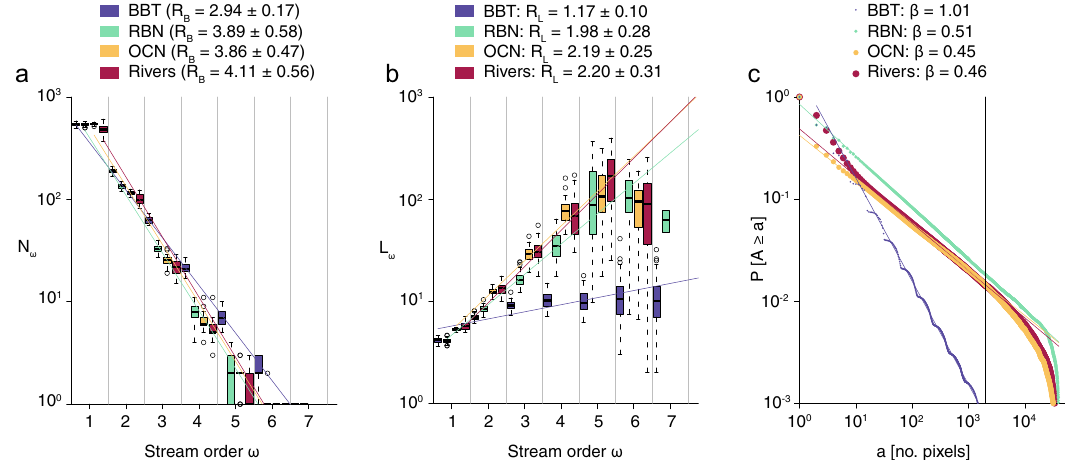
Fig. 5 Comparison of topological and scaling properties of the different networks. a Scaling of number of network links N ω as a function of stream order ω for the various network types (rivers and OCNs obtained with A = 20 pixels; RBNs and BBTs derived accordingly - see Methods). b Mean link length L ω T (in units of l ) as a function of ω . Networks used are as in panel a. c Scaling of drainage areas: probability P [ A ≥ a ] to randomly sample a node with drainage area A ≥ a as a function of a . The displayed trend lines are fi tted on the ensemble values for the 50 network replicates, by excluding nodes with drainage area larger than 2000 pixels (cutoff value marked with a black solid line). The scaling coef fi cients β reported correspond to the slopes of the fi tted trend lines. Extended details on all panels are provided in the Supplementary